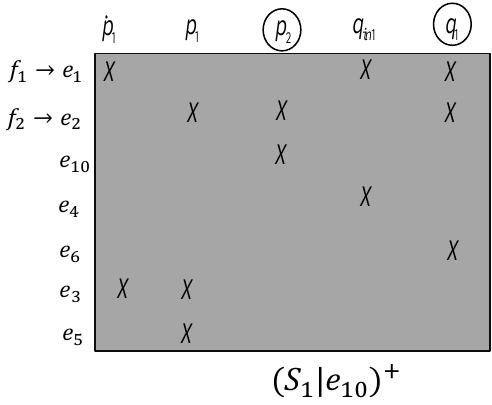
Figure 3. DM decomposition of S 1 e 10 = ( S 1 | e 10 ) .